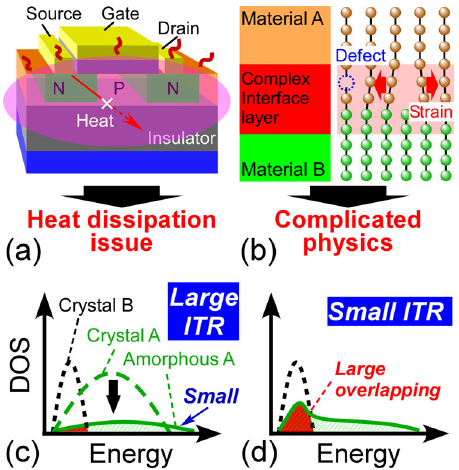
Fig. 1 Schematics of thermal transport physics through the interface. a Schematic of heat dissipation issue in large scale integrated circuit. b Phonon transport at the interface between materials A and B. c Small and d Large overlappings of vibron-phonon density-of-states (DOS) between amorphous and epitaxial crystals related to the large and small interface thermal resistance per unit area (ITR),